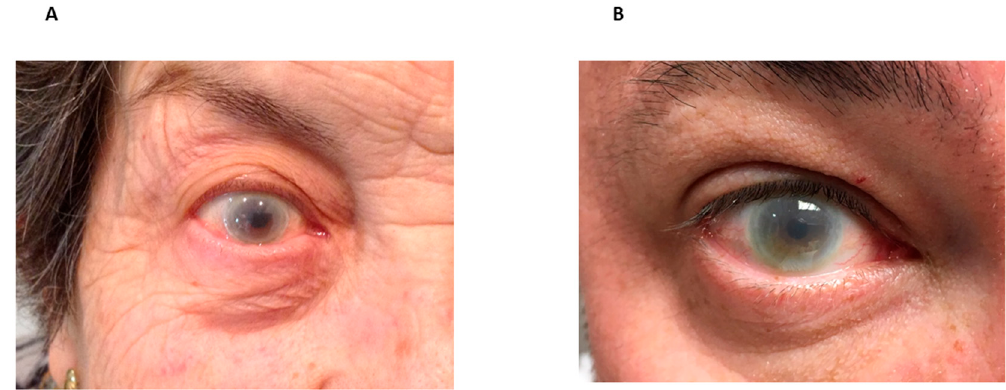
Figure 1. Corneal opacity in FLD patients. Corneal opacity from second case ( A ) and third case ( B ) are shown.